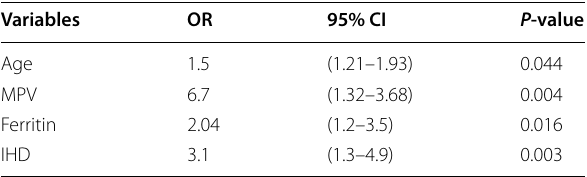
Continuous data represented as mean and SD, and categorical data represented as number and percentage (%).*Independent samples Student’s t -test; ‡ chi- square test; P < 0.05 is significant; LOS , length of stay Table 6 Predictors of severity of COVID-19 patients